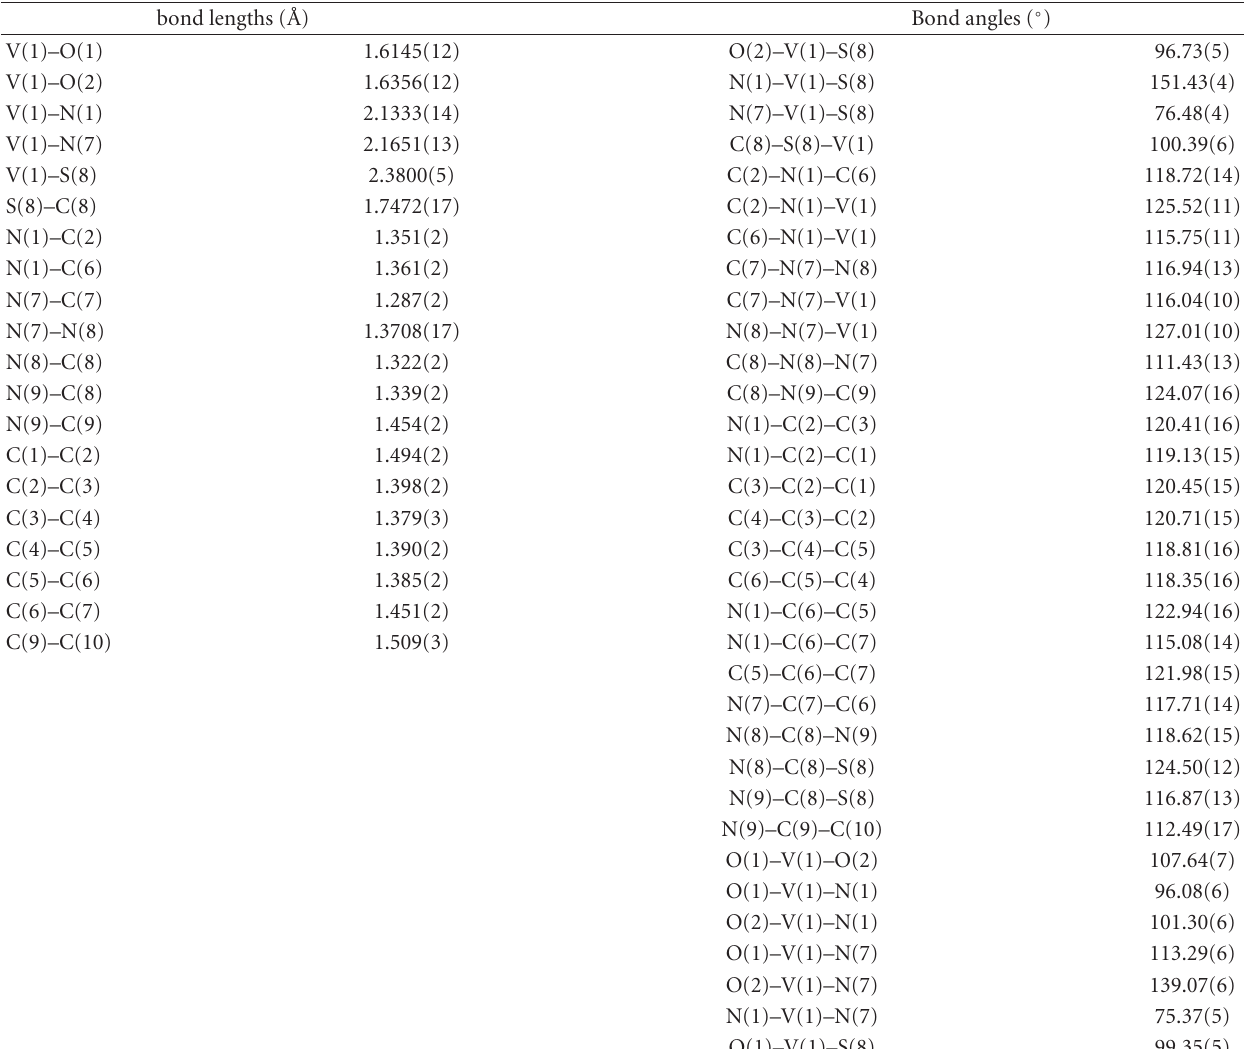
Table 5: Selected bond lengths and bond angles for [VO 2 (mpETSC)].